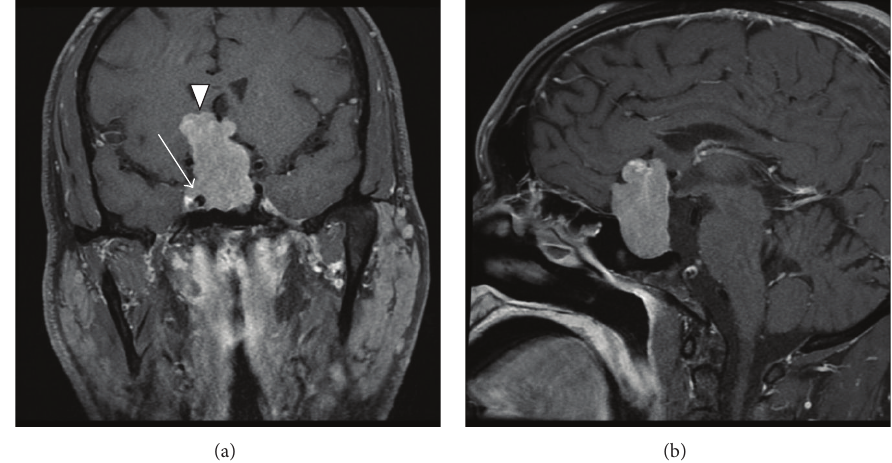
Figure 1: MRI of the sella. T1-weighted, postgadolinium coronal (a) and sagittal (b) images show a hyperdense lesion that expands the sella and extends intracranially (arrow head) through the suprasellar space to compress the optic nerves and chiasm. In the coronal view, one can see the tumor wrapping above the right carotid artery in the cavernous sinus (arrow).